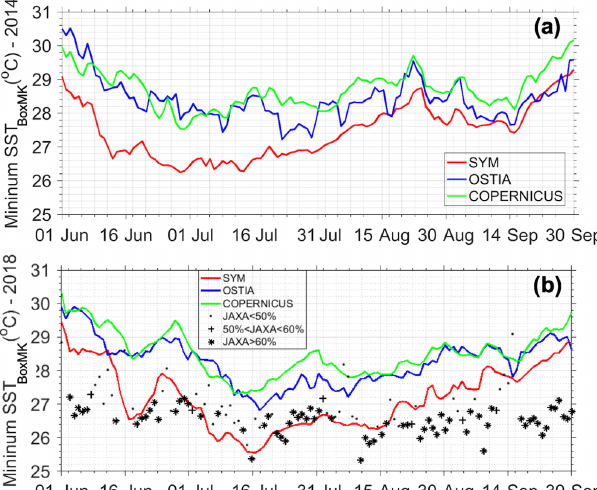
Figure 5. Daily time series of minimum SST ( ◦ C) over BoxMK (a) during summer 2014 in SYMPHONIE, OSTIA, COPERNICUS, and (b) during summer 2018 in SYMPHONIE, OSTIA, COPERNICUS, and JAXA. Dots, crosses, and stars cor- respond, respectively, to a spatial coverage of BoxMK lower than 50%, higher than 50%, and higher 60% for JAXA. We only con- sider JAXA pixels of quality levels ≥